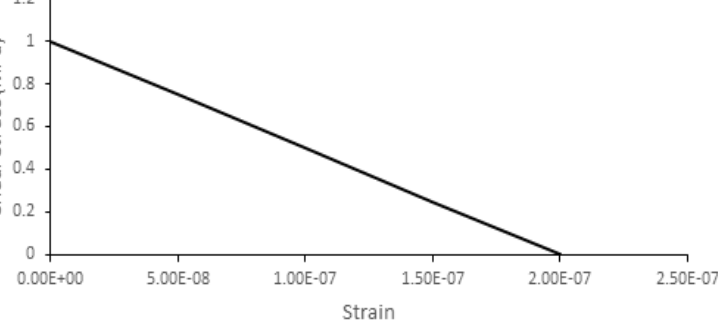
Figure 6. Shear retention model values for both cortical and sutures tissues.